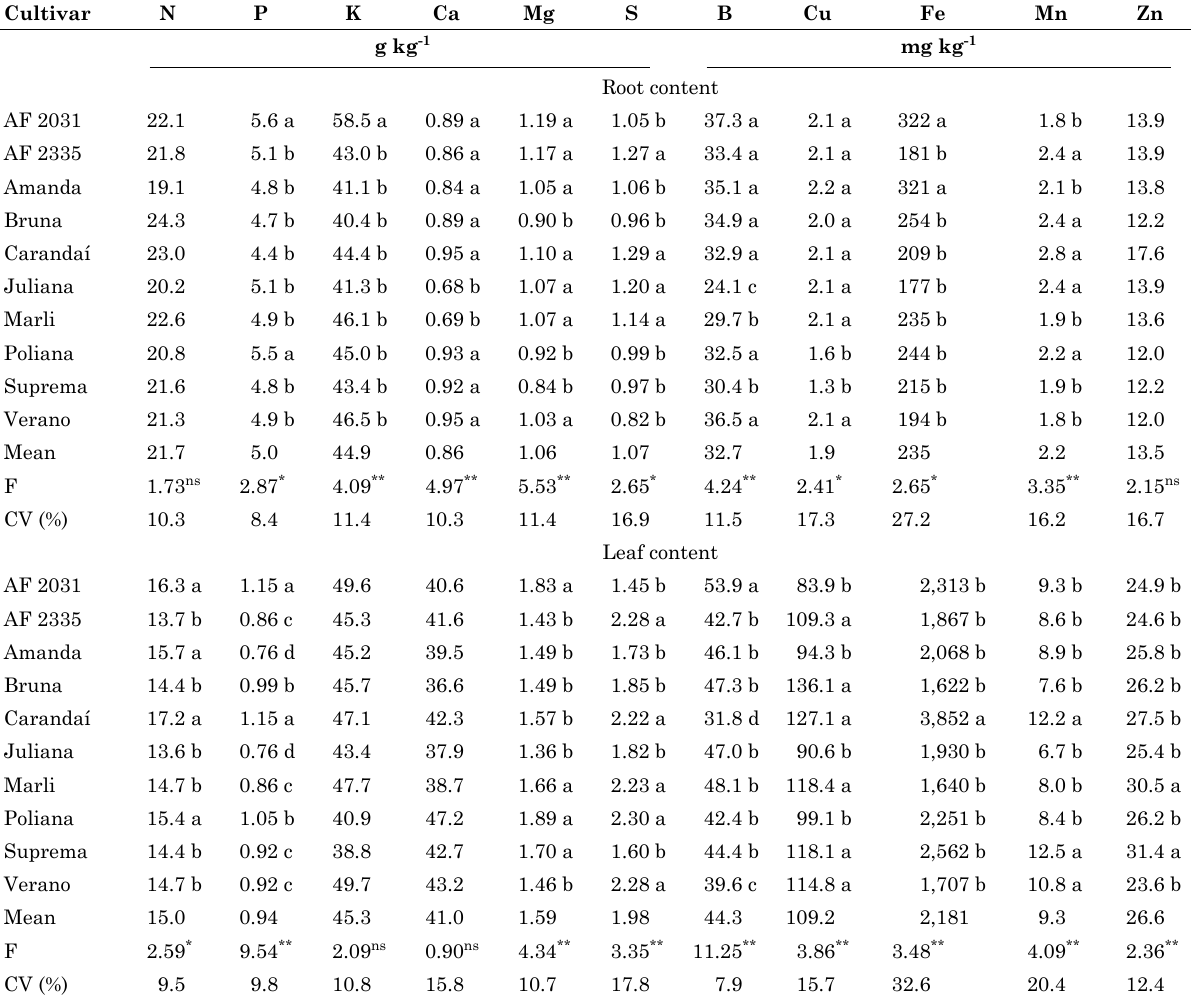
Table 3. Nutrient contents in the roots and leaves of summer carrot cultivars sown in the summer crop season (Experiment